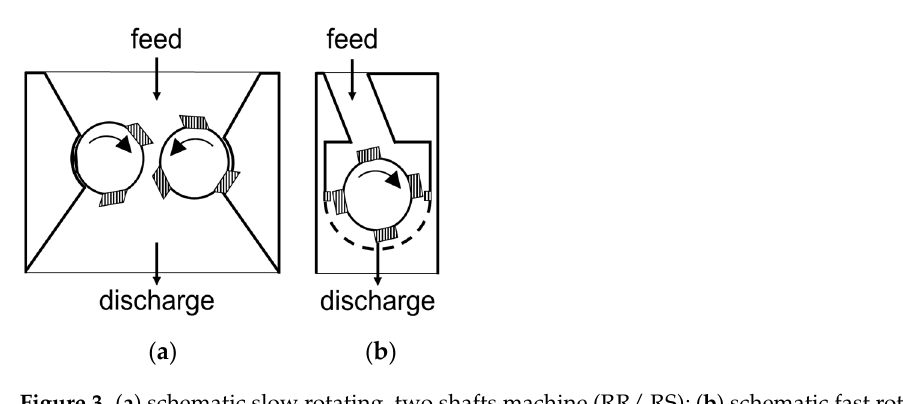
Figure 2. Flow chart of experimental procedure (RR: slow rotating, two shafts rotary shear with axial gap, RS: slow rotating, two shafts rotary shear without axial gap, UG: one shaft rotary shear with outlet grid); reprinted with permission from [9].